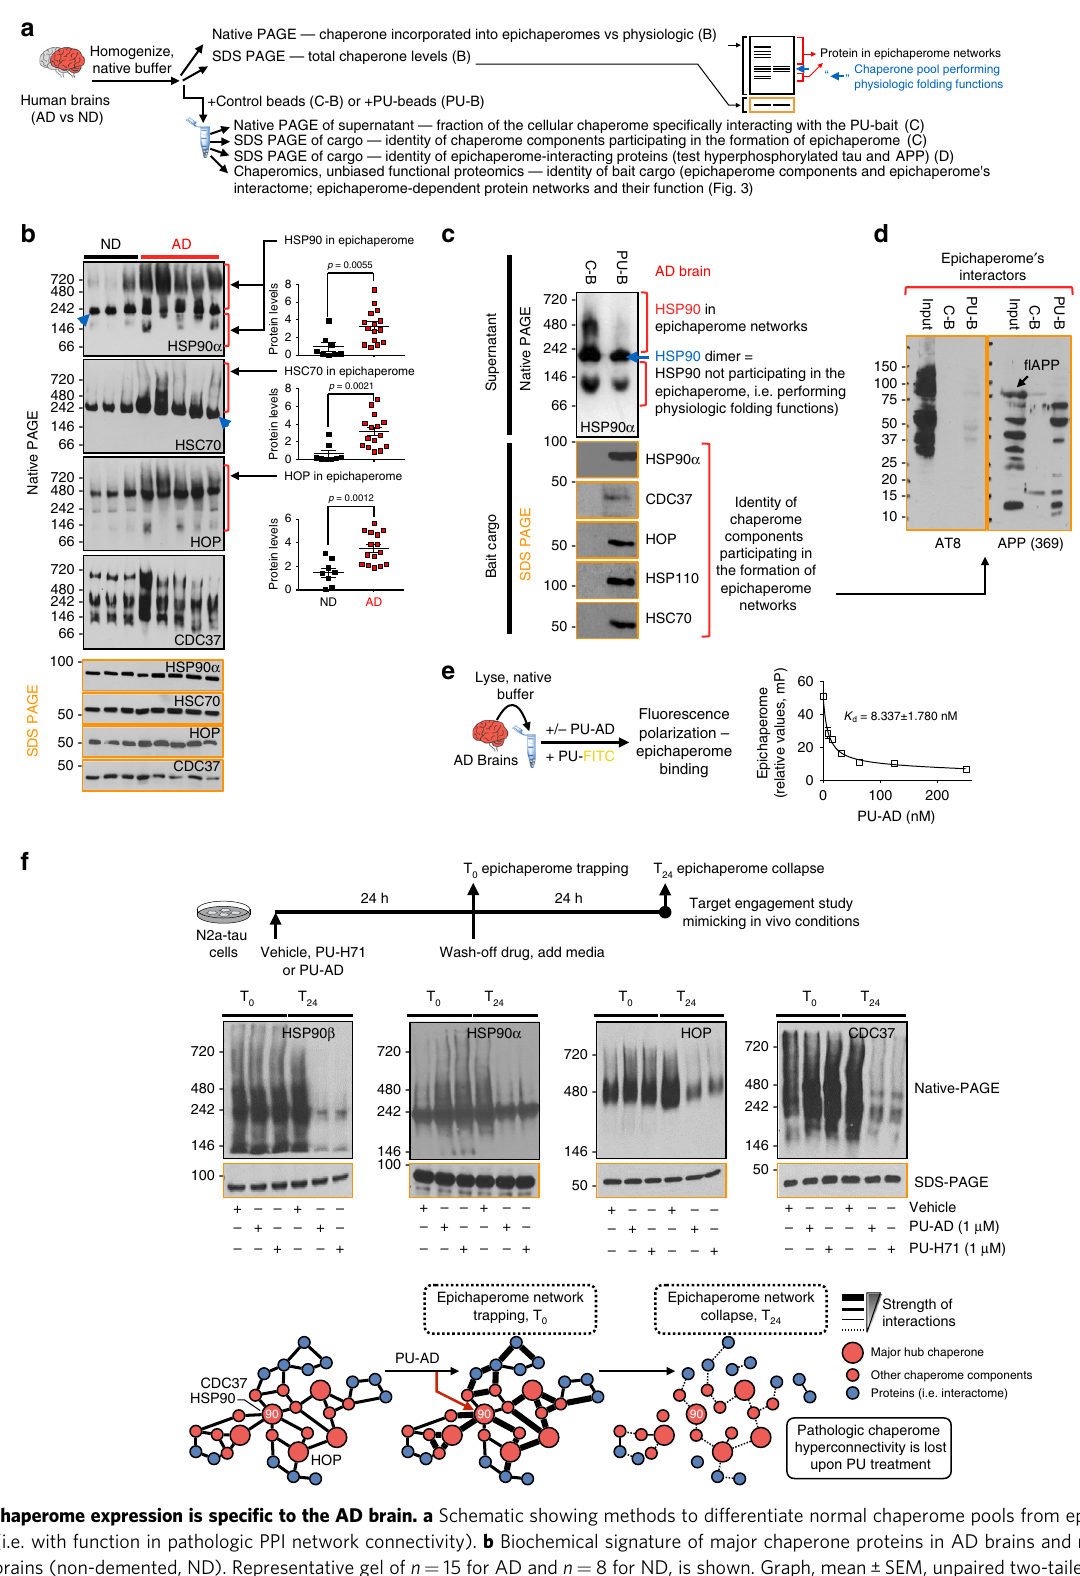
Fig. 2 Epichaperome expression is speci fi c to the AD brain. a Schematic showing methods to differentiate normal chaperome pools from epichaperome networks (i.e. with function in pathologic PPI network connectivity). b Biochemical signature of major chaperone proteins in AD brains and normal, age- matched, brains (non-demented, ND). Representative gel of n = 15 for AD and n = 8 for ND, is shown. Graph, mean ± SEM, unpaired two-tailed t -test. See also Supplementary Fig. 3. c , d Af fi nity-puri fi cation of the epichaperome and its AD interactome shows no speci fi c interaction between the epichaperome and hyperphosphorylated tau or full-length APP ( fl APP). Data representative of n = 3 individual AD brains. PU-bait (PU-B); control bait (C-B). e Binding of PU-AD to the epichaperome in AD brain homogenates. Graph, mean ± SEM, n = 3 replicates. f PU-AD disrupts the epichaperome network. Schematic of the experimental design and the biochemical signature of select epichaperome network components are shown. Representative data of n = 3 independent experiments. Source data are provided as a Source Data fi